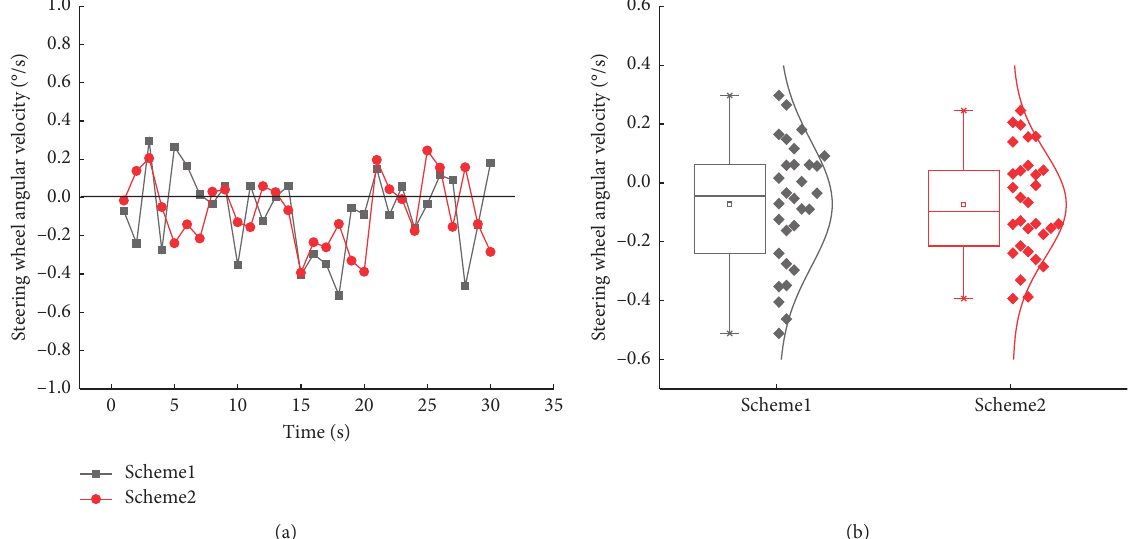
Figure 8: Angular velocity of driver’s steering wheel for different left lateral clearances. (a) Angular velocity change of different schemes. (b) Comparison of angular velocity box plots of different